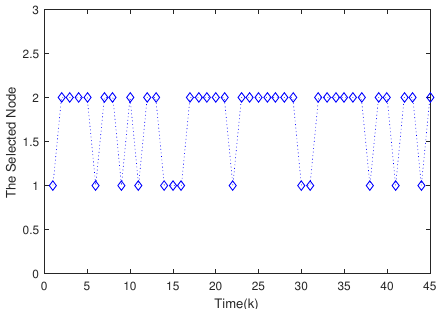
Figure 13. The evolutions of selected node under the RAP scheduling .